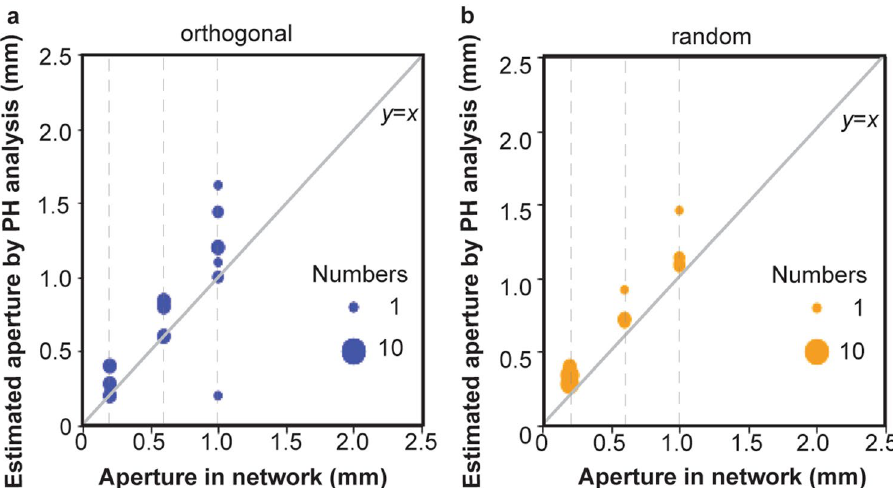
Figure 4. Estimation of fracture apertures by persistent homology (PH) analysis. ( a ) Orthogonal fracture networks and ( b ) random fracture